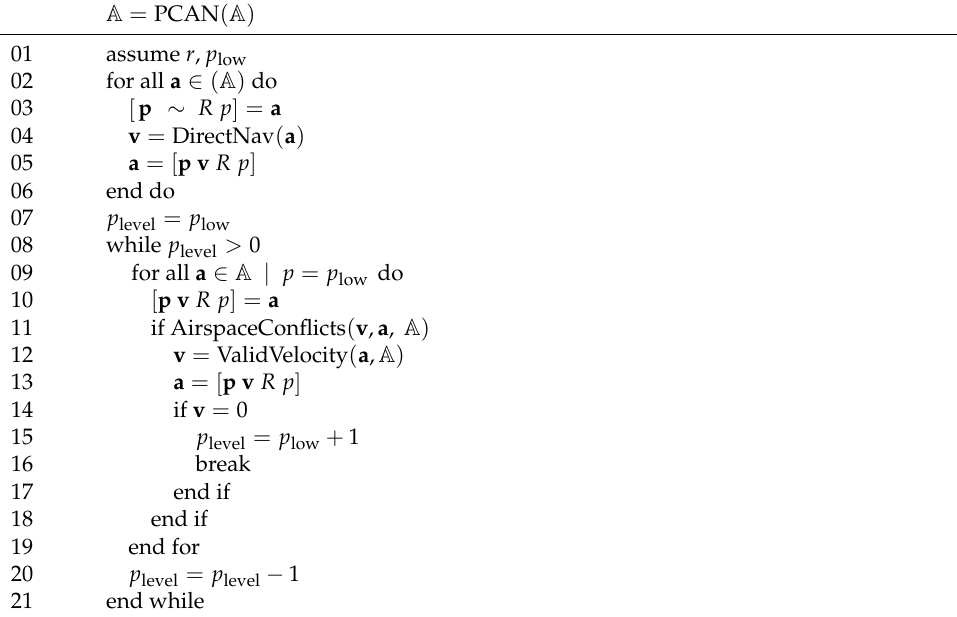
Table 2. Priority-aware version of the PCAN